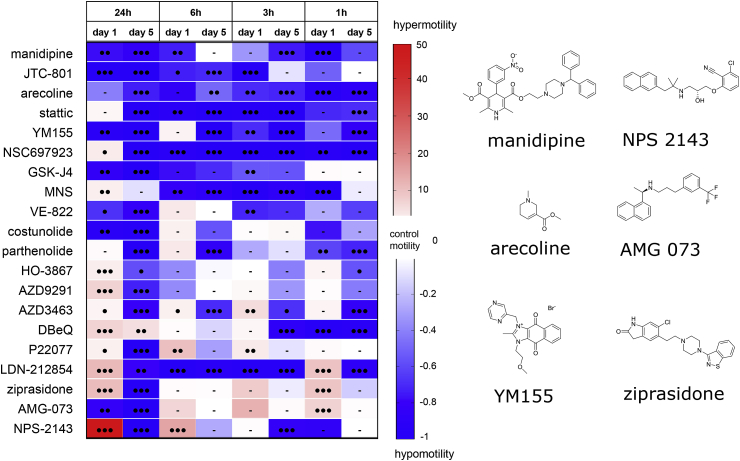
Motility assay on schistosomulae treated with selected hits over decreasing incubation periods.Heat map of compounds significantly impairing parasite motility (larval and adult stages). Motility assays were performed on three-day old schistosomulae and consisted of two motility recording time points (day 1 and day 5) following a 1–6 h compound incubation time. Motility rate was calculated relatively to control animals (DMSO-treated). Blue and red colors correspond to hypo- and hypermotility, respectively. Black circles indicate p value < 0.0005 (3), <0.005 (2), <0.05 (1). N.S indicates no significant change in motility rate compared to control. Shown on the right are chemical structures of key compounds showing hypo- and hypermotility patterns. (For interpretation of the references to color in this figure legend, the reader is referred to the Web version of this article.)